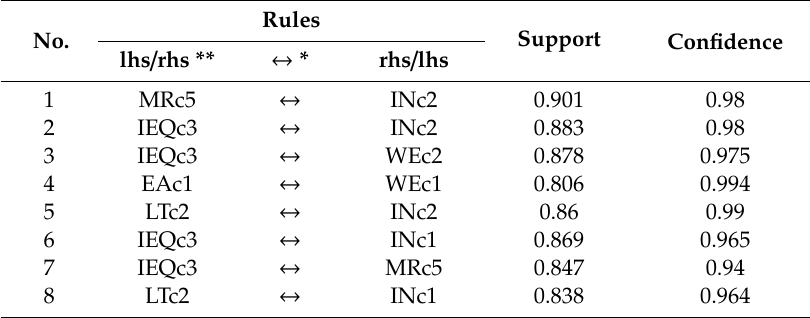
Table 4. The results of the association rule